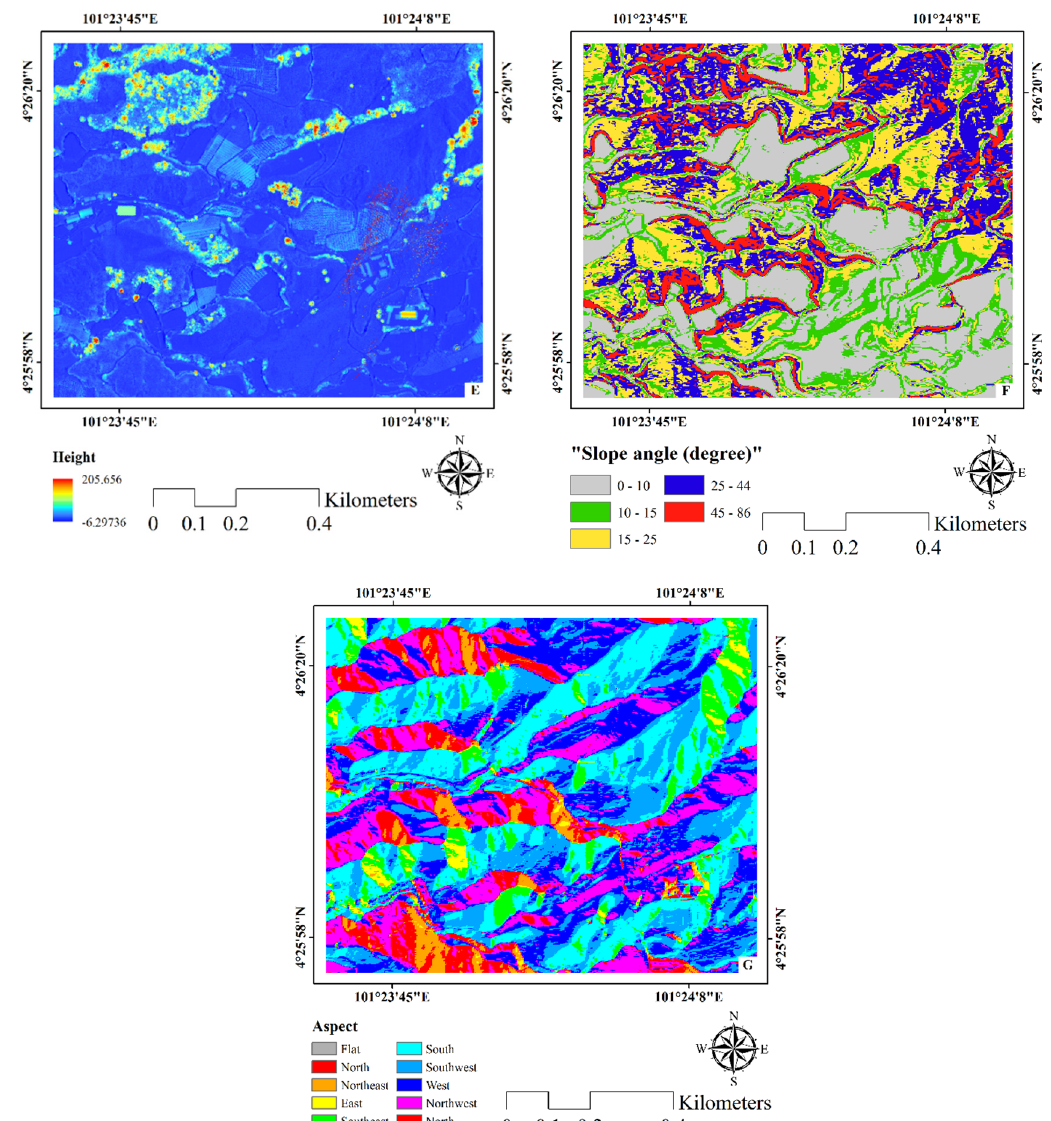
Figure 4. LiDAR-derived data; ( A ) Orthophotos; ( B ) digital terrain model (DTM); ( C ) digital surface model (DSM); ( D ) Intensity; ( E ) Height; ( F ) Slope; and ( G ) Aspect.